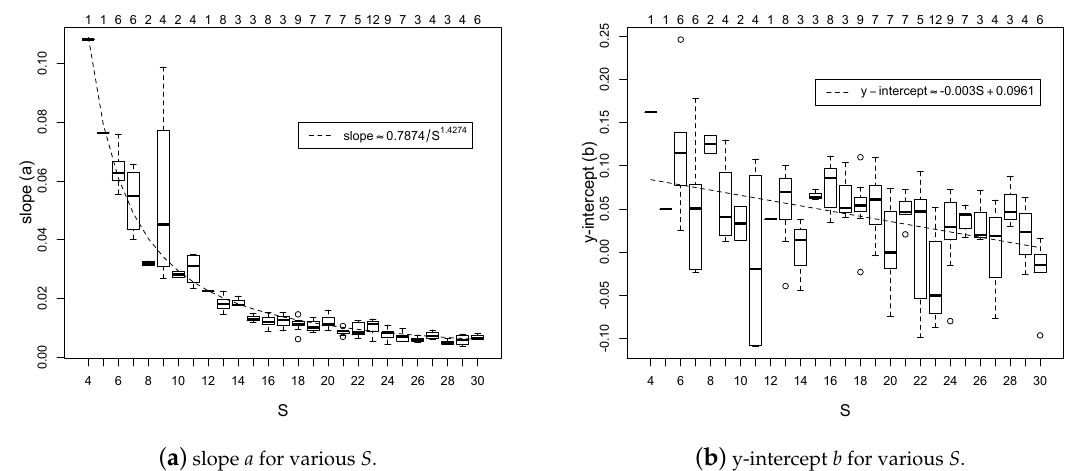
Figure 3. Slope a and y-intercept b for various networks of size S ≤ 30, given by the Internet Topology Zoo collection. Top axis gives the number of samples for each S . The dashed lines model the regression between the boxplot medians and S